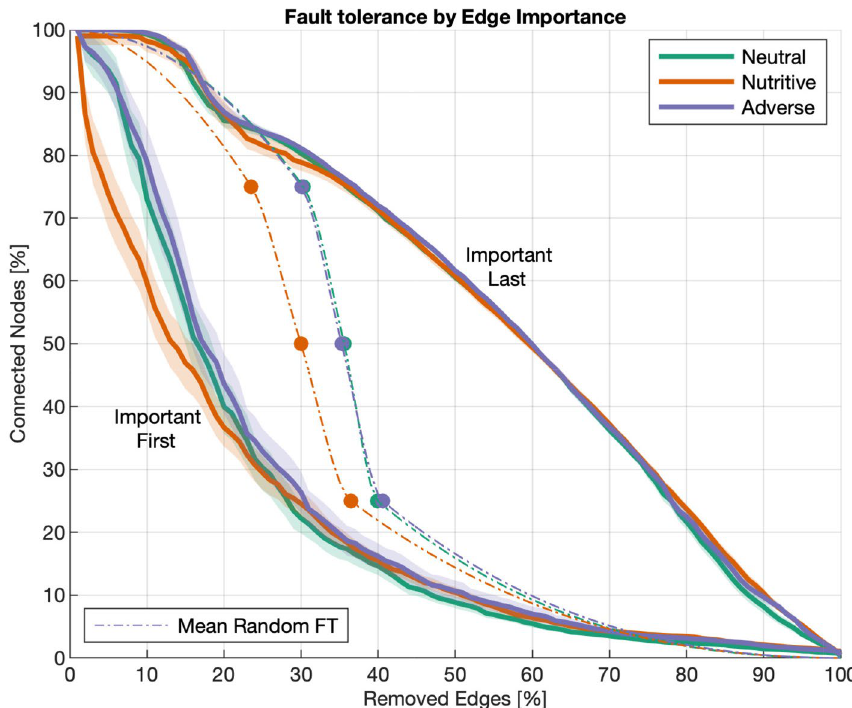
Figure 14. Fault tolerance Decay. Fault tolerance by edge importance. Decrease of the percentage of connected nodes in the graph (vertical axis) as a function of edge removal (horizontal axis). Dashed lines correspond to the mean random tolerance calculated for 25%, 50% and 75% of the nodes, connected by a spline. Solid lines and shaded regions correspond to the mean and confidence intervals (CI) for the worst and best case scenarios, resulting from removing the most important edges first and last,